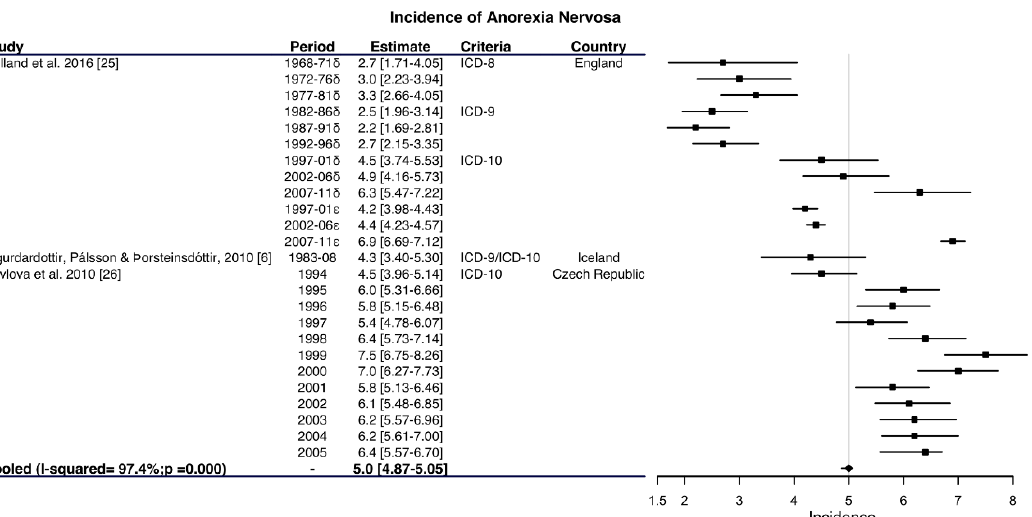
Figure 2. Forest plot of the meta-analysis of the anorexia nervosa incidence rates in women in hospital